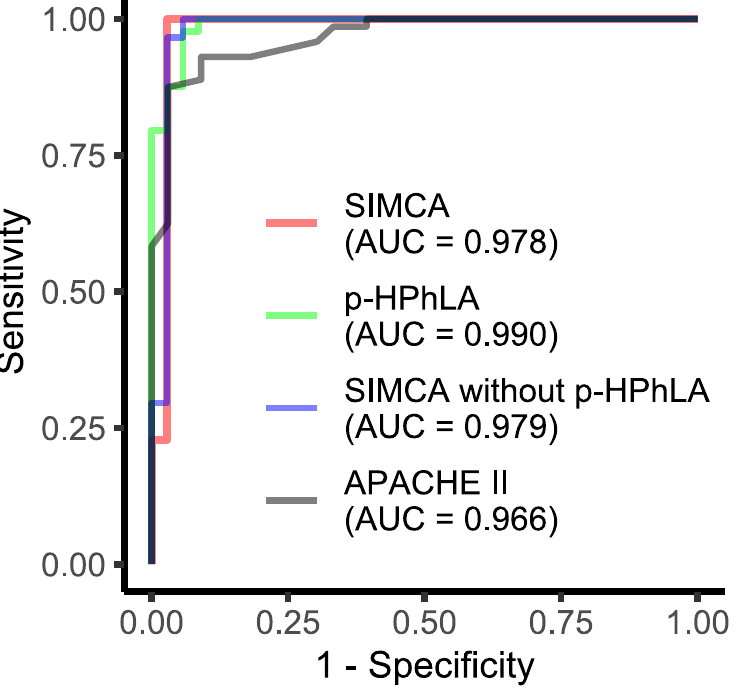
Figure 4. ROC curves obtained for univariate models based on the p -HPhLA concentration and clinical APACHE II scale, and multivariate models based on the profile of the 8 aromatic metabolites, including p -HPhLA, and on the profile of the 7 aromatic metabolites without p -HPhLA.